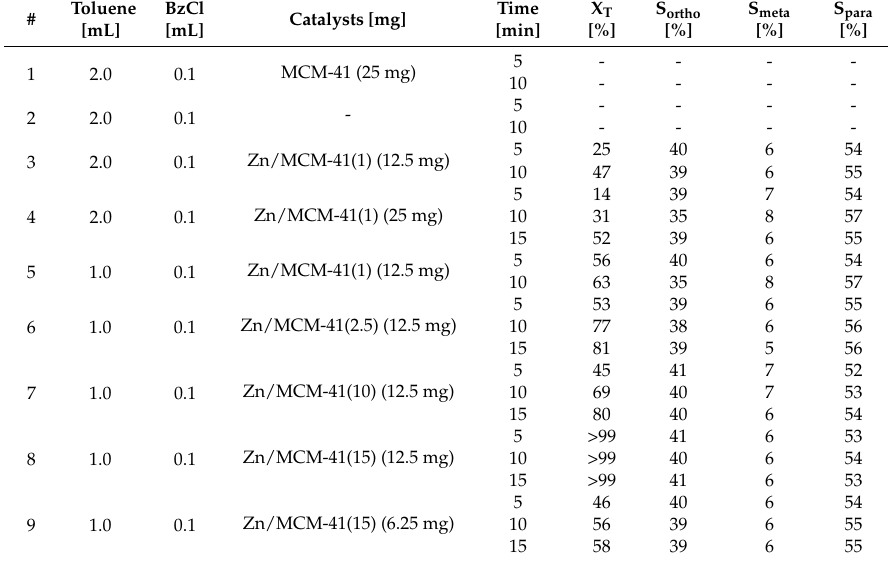
Table 3. Activities and selectivity of Zn/MCM-41 in the alkylation of toluene with benzyl chloride under microwave irradiation (a)